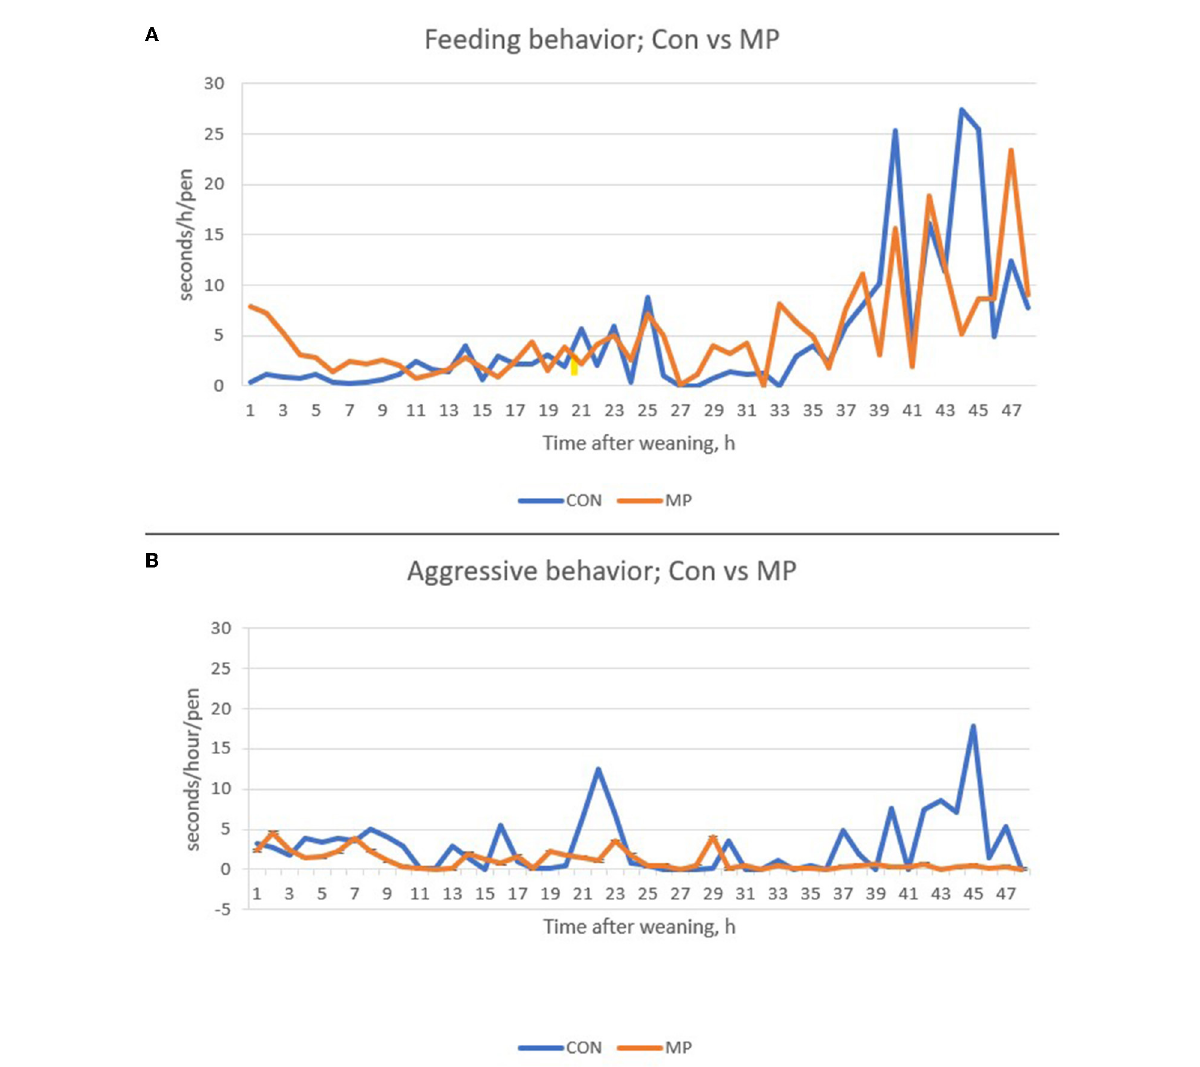
FIGURE3 Aggressive behavior (A) and feeding behavior (B) of pigs in Study 1 that had control (Con) or maternal pheromone (MP) exposure. The MP treatments of Bead and Sponges are combined because they did not differ from each other. Table 2 presents the means for Con and MP treatment groups over the first 24h after weaning. Note that overall, MP reduced aggression by about 38% and increased feeding behavior about 28% (see Table 3). Lying behavior was not different among treatments. N = 4 pens for the control and N = 8 pens for the MP treatment. A total of 48 pigs were evaluated. Sep = 1.78 for aggressive behavior and 2.35 for feeding behavior. Within time points, treatments differed for aggressive behavior at hours 23, 40, 42, 43, 45, and 47h while feeding behavior differed between treatments at time points 1, 2, 40, 44, and 45h after weaning ( P <